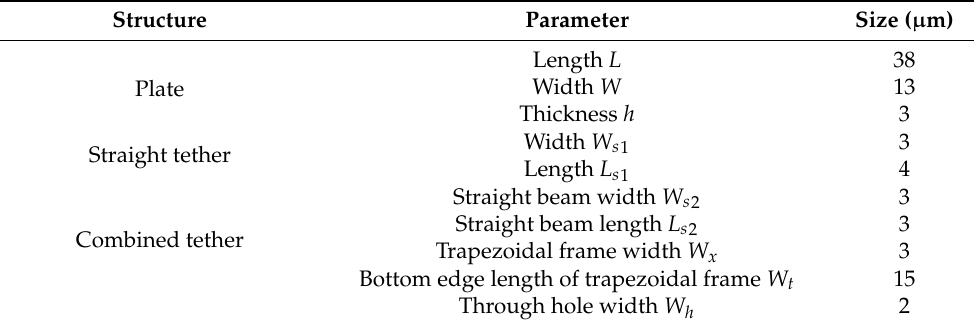
Table 1. Table 1. The optimized size of the WEM resonator with the combined